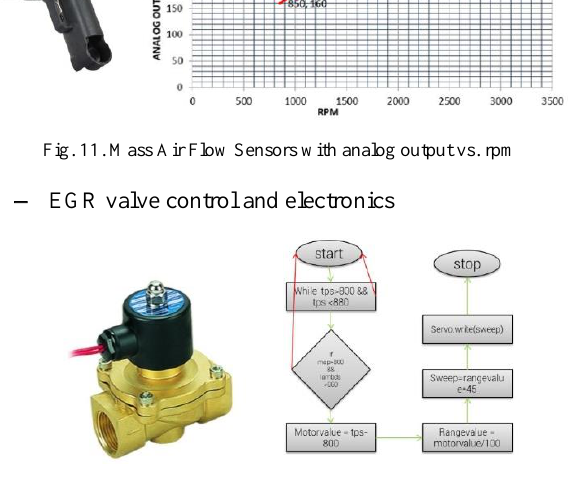
Fig. 12. EGR valve with Arduino code for motor control